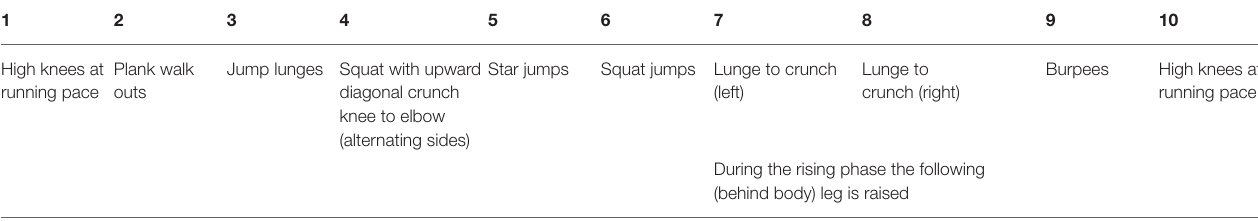
TABLE 1 | Activities in the exercise